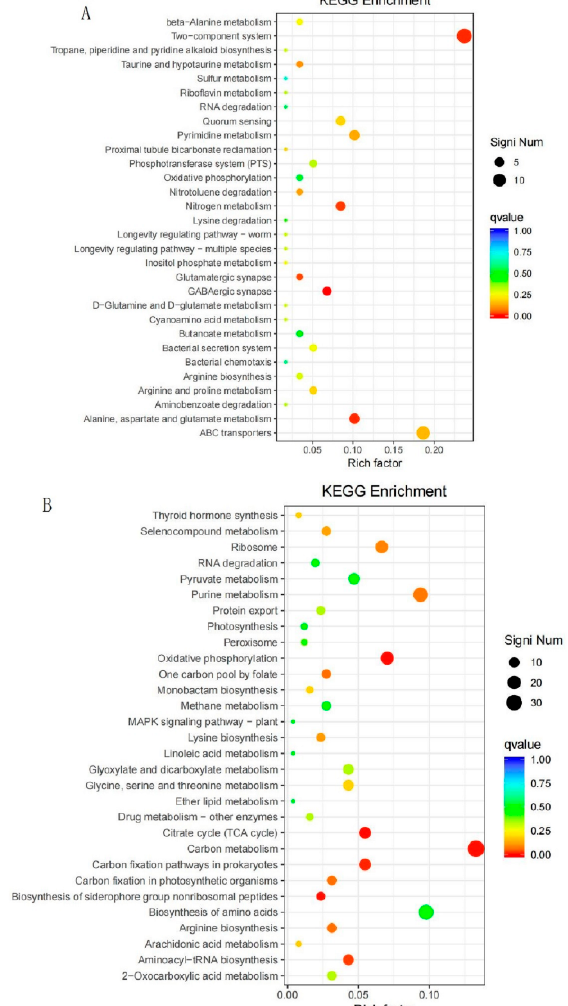
Figure 5. Scatter plot of DEGs Kyoto Encyclopedia of Genes and Genomes (KEGG) enrichment function. ( A ) Upregulated genes analysis results; ( B ) downregulated genes analysis results.